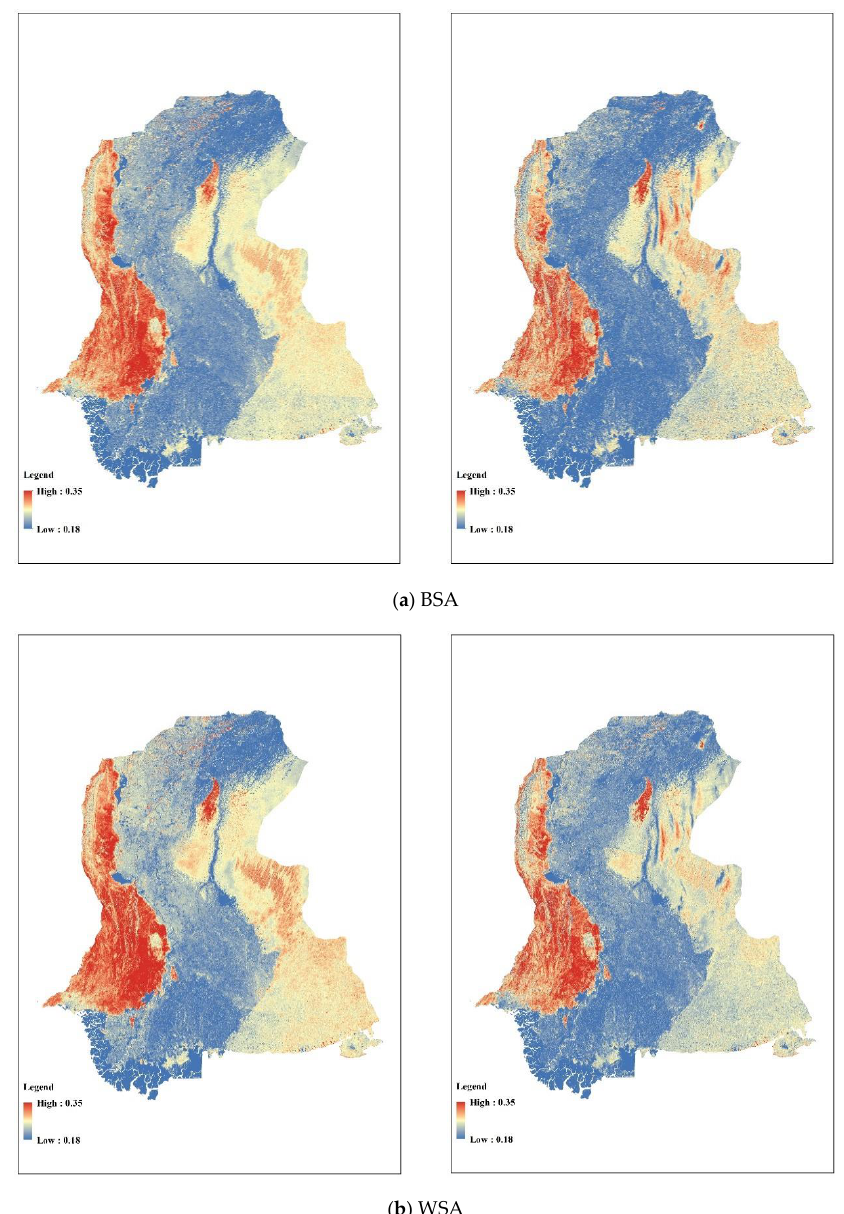
Figure 8. Comparison of ( a ) black-sky albedo and ( b ) white-sky albedo of GF-1 (left) and Landsat-8 (right) in Sindh.